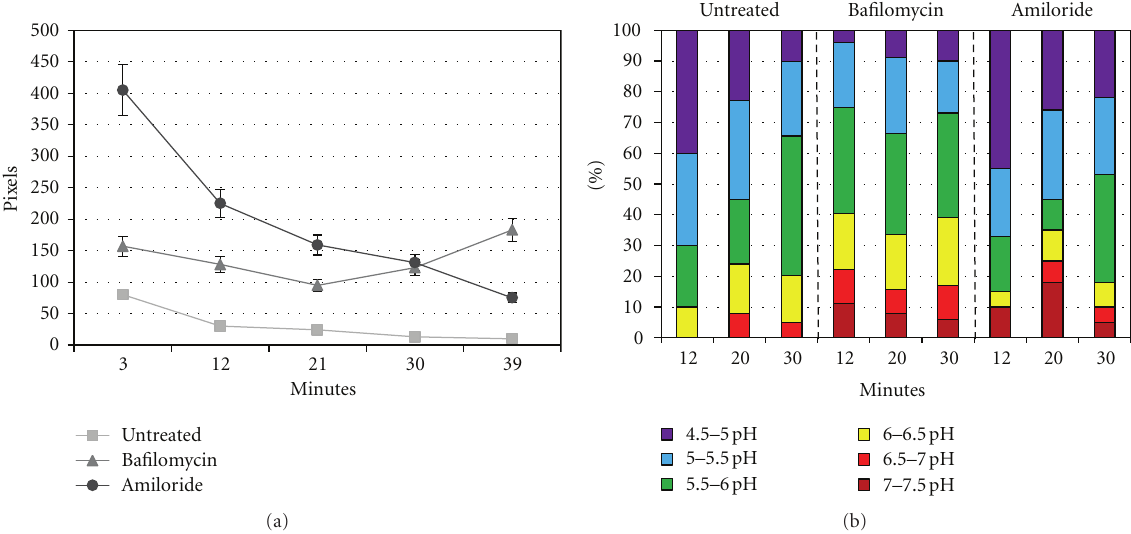
Figure 8: Pharmacologic e ff ects on nanosensors at 37 ◦ C. Cells incubated at 37 ◦ C with the addition of bafilomycin or amiloride for two hours, followed by the addition of nanosensors. (a) Demonstration of total pixel/nanosensor number averaged from three individual cells. Cells are incubated at 37 ◦ C untreated or treated for two hours with drug, followed by the addition of nanosensors for ten minutes, then imaged. (b) Demonstration of the percentage of nanosensors averaged from three cells, from the whole, within the assigned pH groupings. Reprinted with permission from Nowak-Lovato et al. [11] (copyright 2010